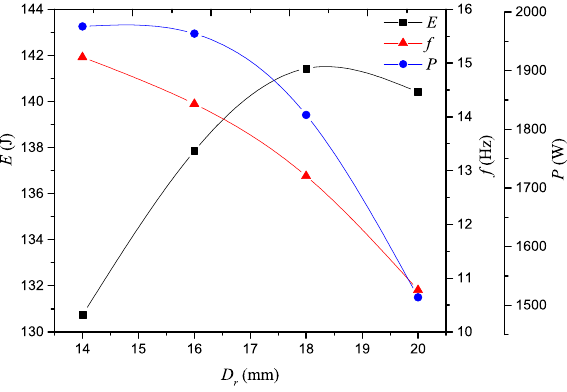
Figure 8. Variations of E , f and P versus diameter of the piston rod D r .